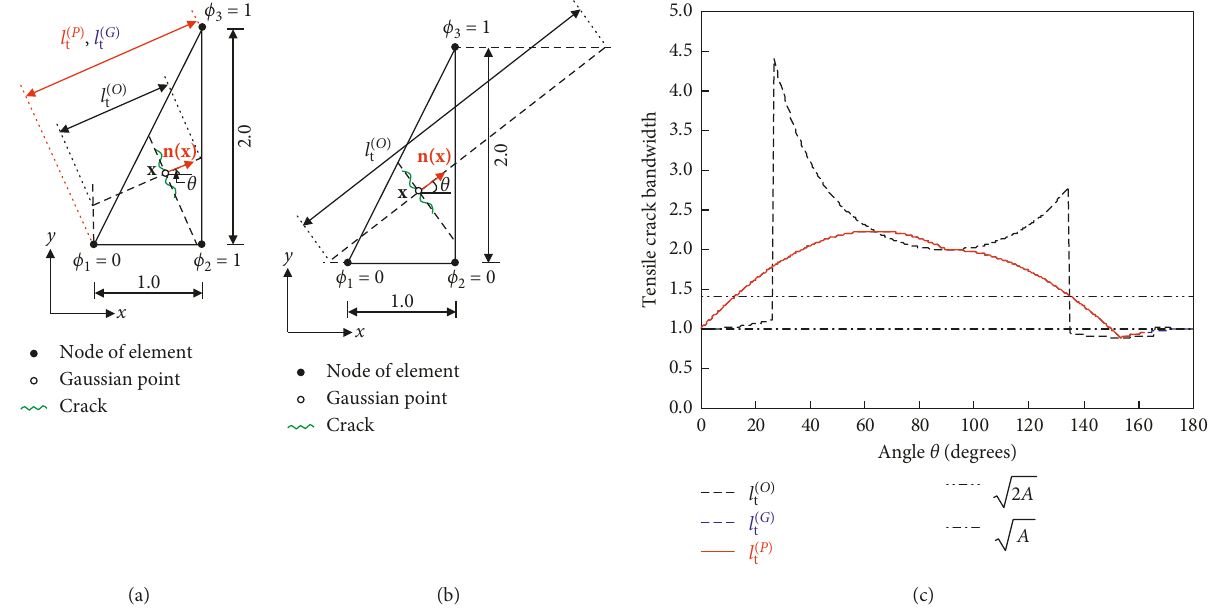
Figure 5: Comparison of estimations of crack bandwidth for a right triangular element: (a) geometrical meanings of crack bandwidths estimated by the present model, Oliver [56], and Govindjee et al. [58]; (b) large crack bandwidth estimated by the first method of Oliver [56]; (c) relations of tensile crack bandwidth and angle θ .